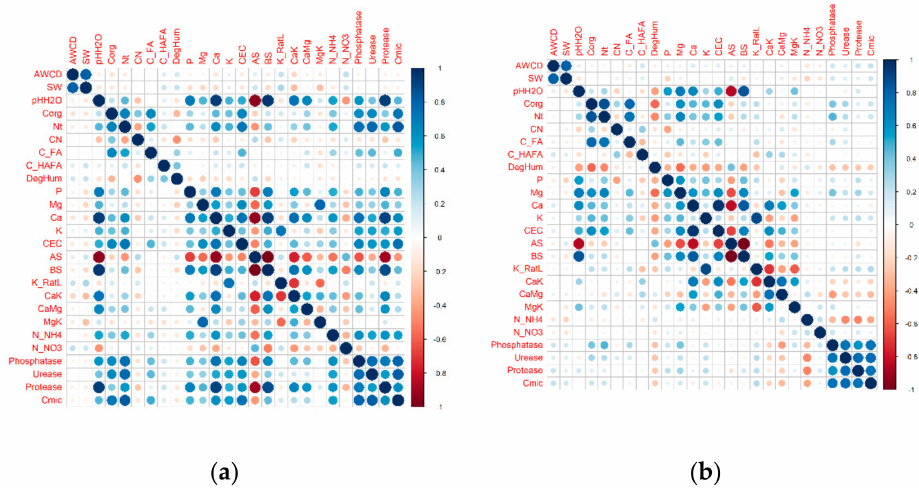
Figure 4. Correlation matrices of diversity indices measured in 2018 with initial soil properties measured in 2017 ( a ) and in 2018 ( b ).